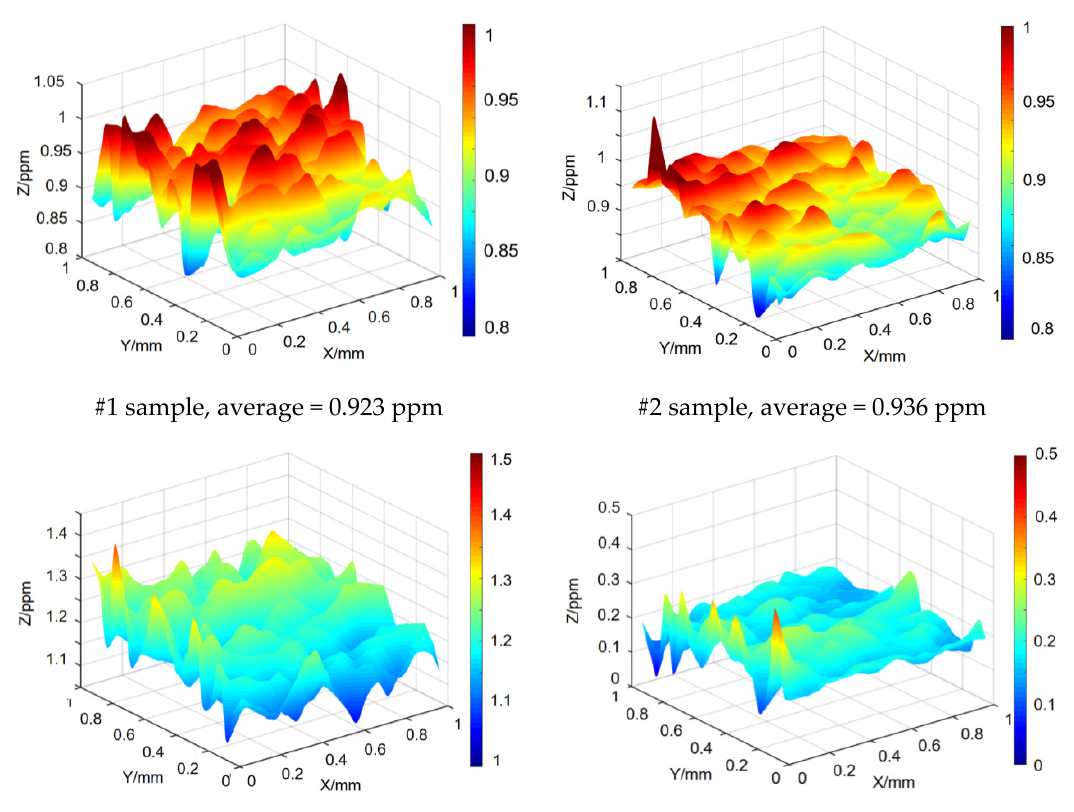
Figure 12. Photothermal weak absorption results of the sample surfaces after different processes (different color indicate the height on Z axis; and ppm, partial per million, means the absorptivity of the irradiation laser energy).